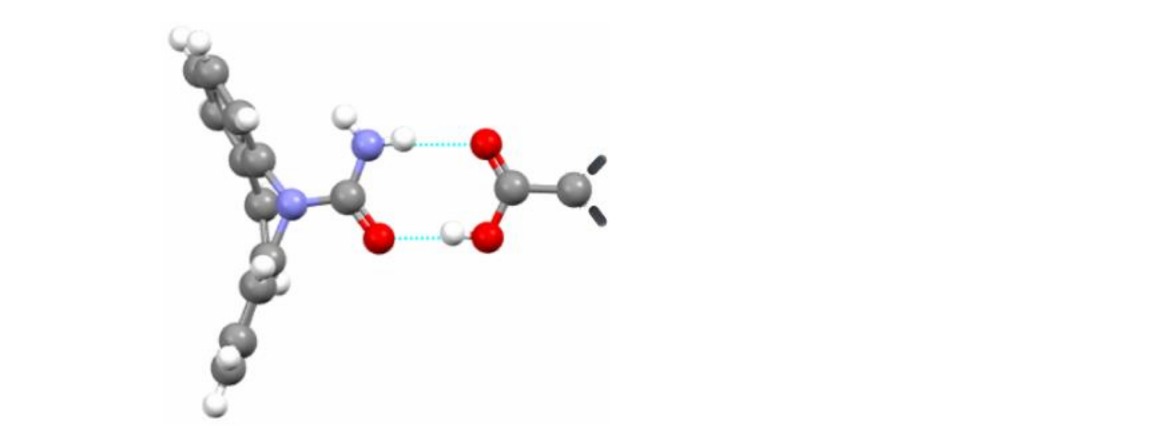
Figure 24. The acid–amide synthon frequently occurring in the co-crystals of carbamazepine with carboxylic